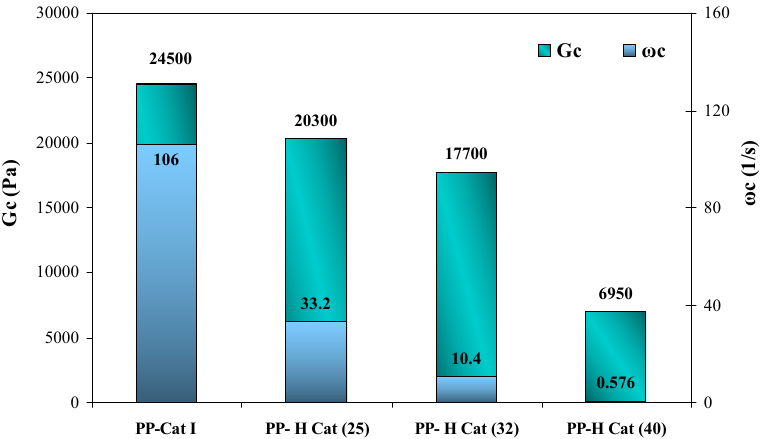
Figure 8. G c and ω C values for the synthesized PP reactor blends at different molar ratios of cat (II)/cat (I).